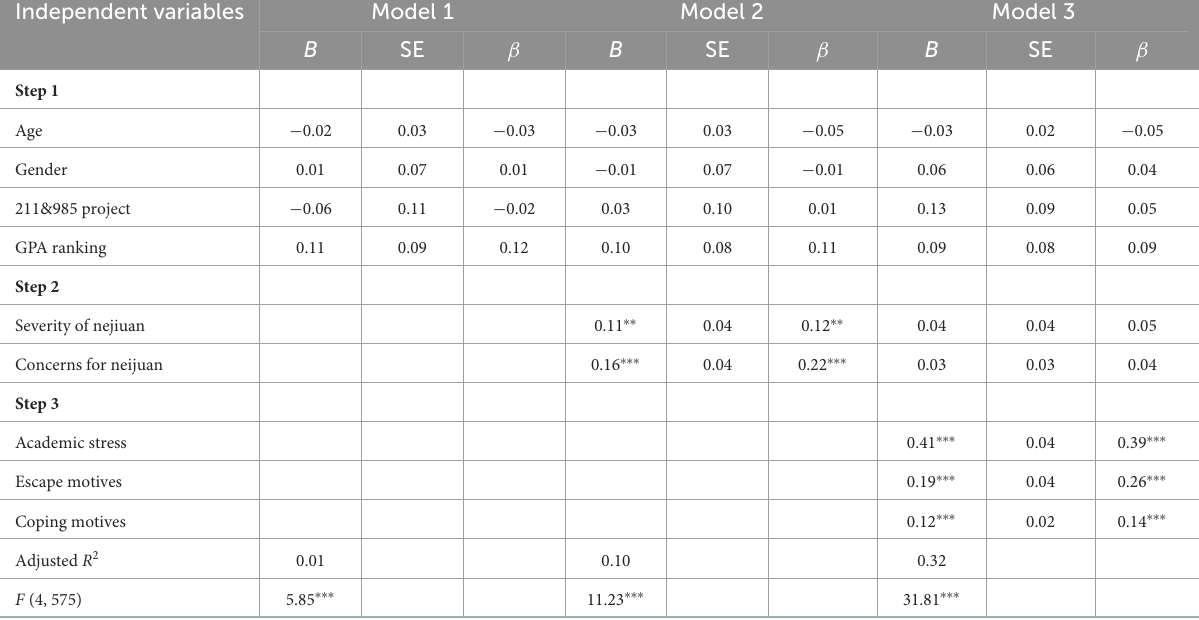
TABLE 6 Hierarchical regression analysis on problematic smartphone use. Independent